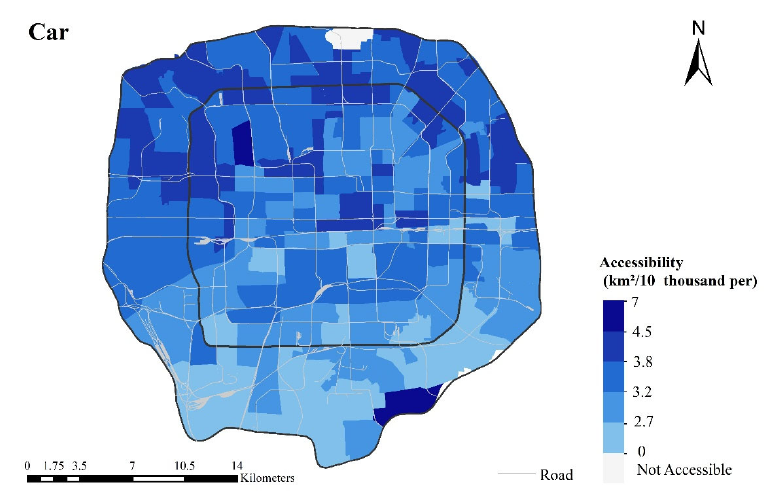
Figure 9. The accessibility results of driving.